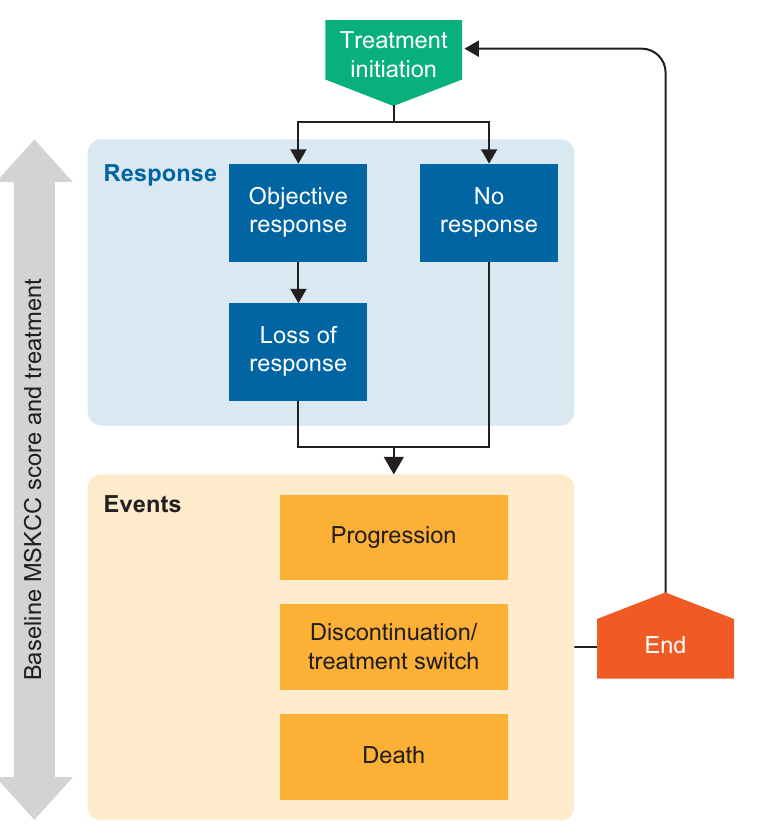
Fig 1. Simulation model structure. Note: Impact of response achievement and loss of response on progression, discontinuation, and death is only considered for the dynamic modeling approach.